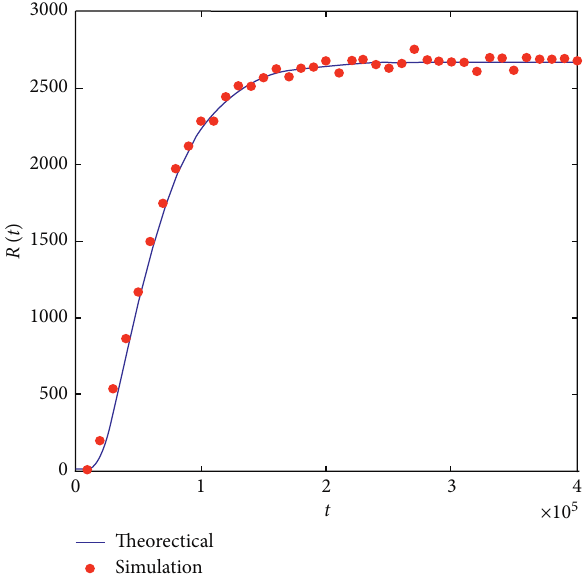
Figure 3: Comparison between theoretical results and